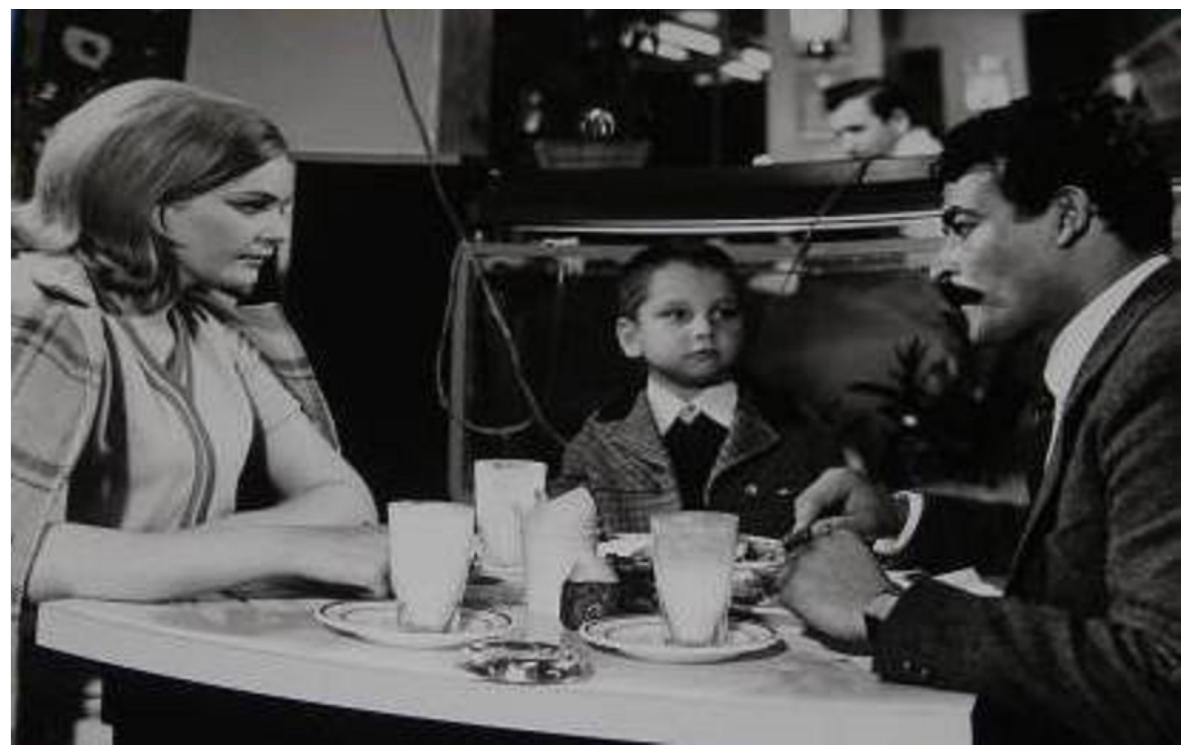
Figure 1: Eva is left alone with her son by his Turkish husband, Ismail, who appears to be westernized in look but acts as a patriarch on the